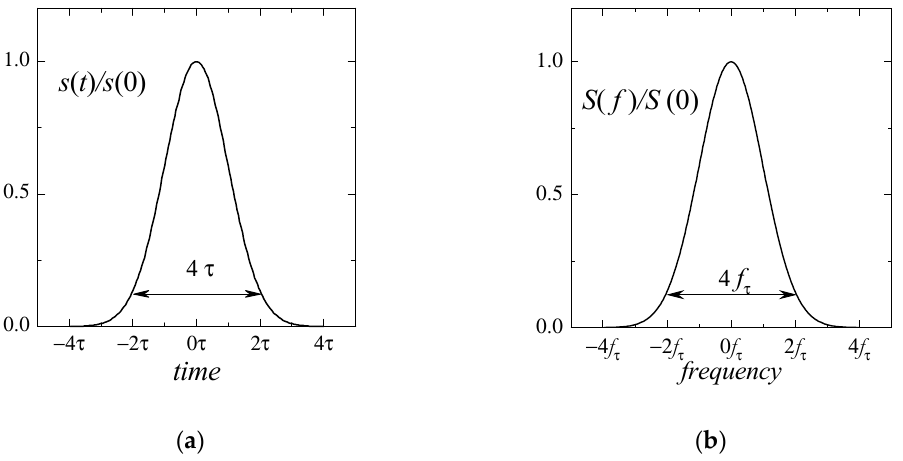
Figure 2. Plots of a base-band Gaussian pulse s ( t ) ( a ) and of its Fourier transform S ( f ) ( b ).